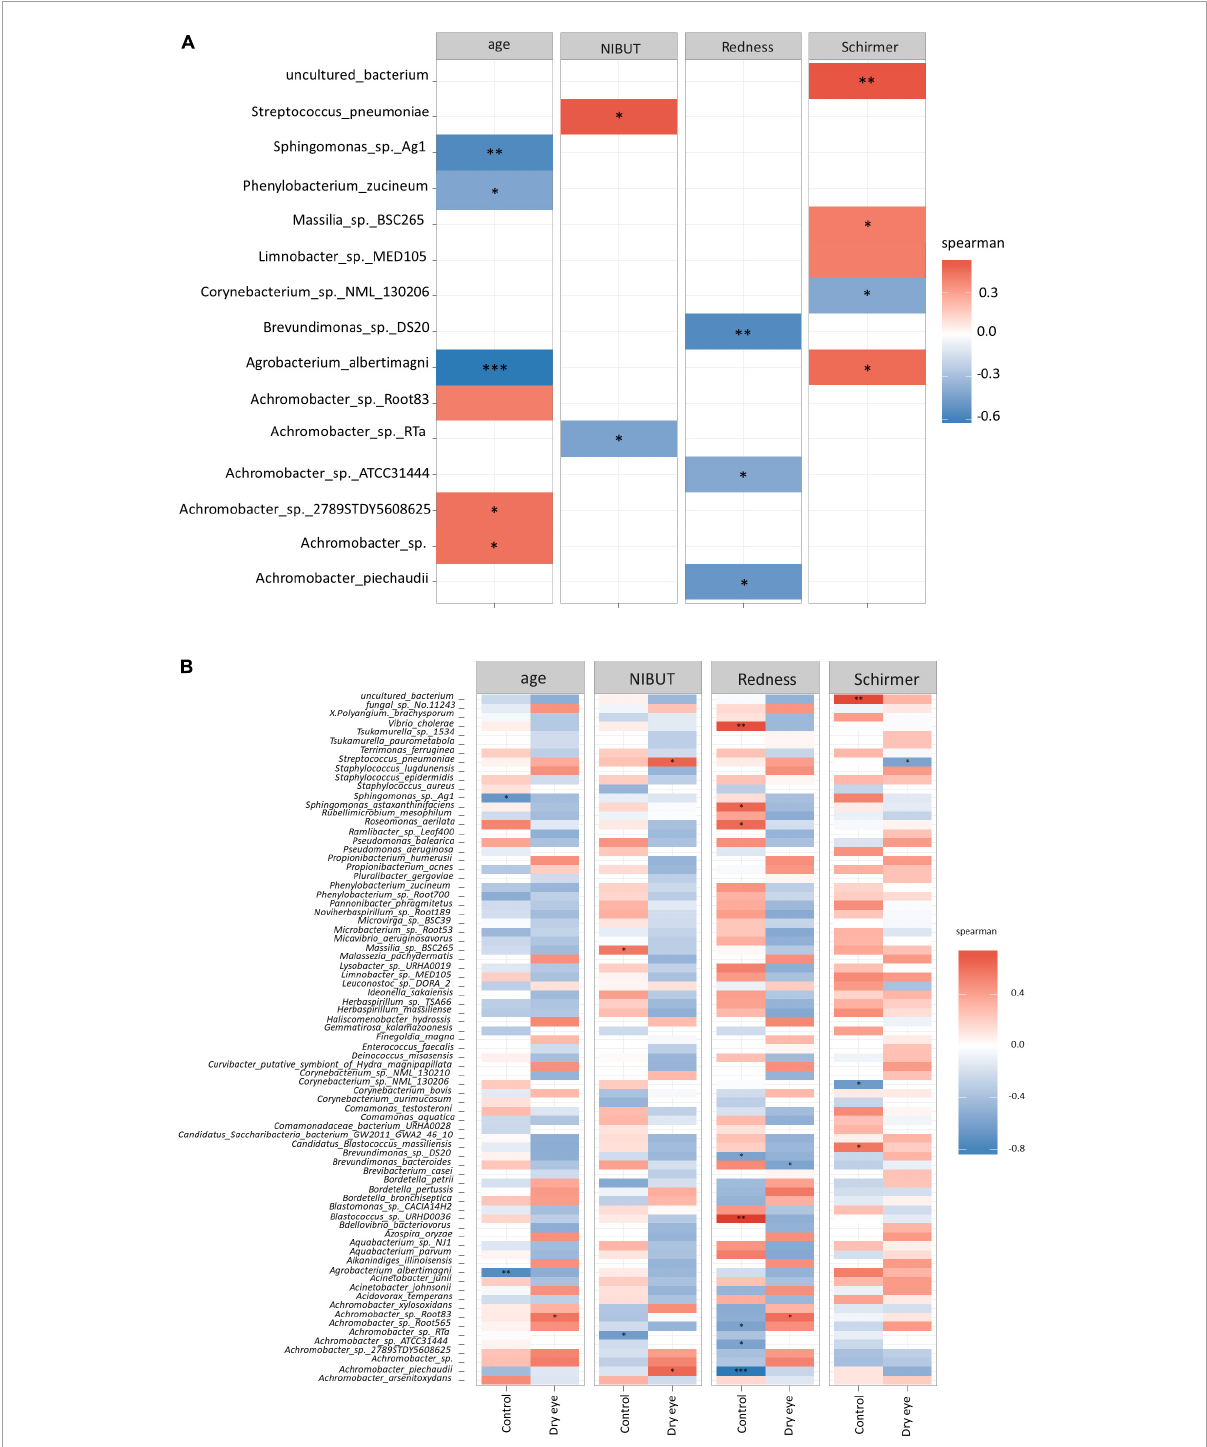
FIGURE4 Correlation between microbial species and demographic/clinical parameters. Each horizontal row indicates a unique microbial species, and the horizontal axis indicates the correlation analysis with age, and three other clinical parameters. NIBUT: Non-invasive tear break up times (in seconds), Redness: Average temporal bulbar redness quantified automatically by Oculus Keratograph K5M; Schirmer: Schirmer I test results (mm over 5 min). The value of the Spearman correlation coefficient, which measures the strength and direction of association between two ranked variables, is color coded. Strong red color indicates positive correlation and strong blue color indicates negative or inverse correlation. Weak or faint color indicates weak or no correlation. (A) All participants included in analysis, and (B) Correlation stratified according to dry eye status (with or without dry eye). ∗ p < 0.05; ∗∗ p < 0.01; ∗∗∗ p <